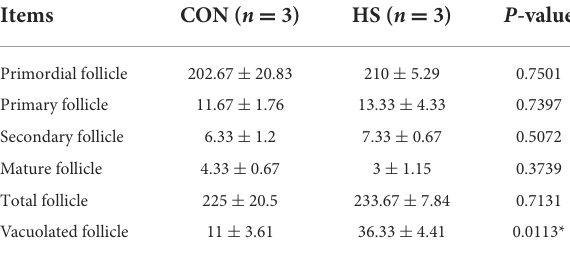
TABLE 3 The number of follicles in various stages for the ovary of female rabbits ( n = 3 per group), as affected by HS.